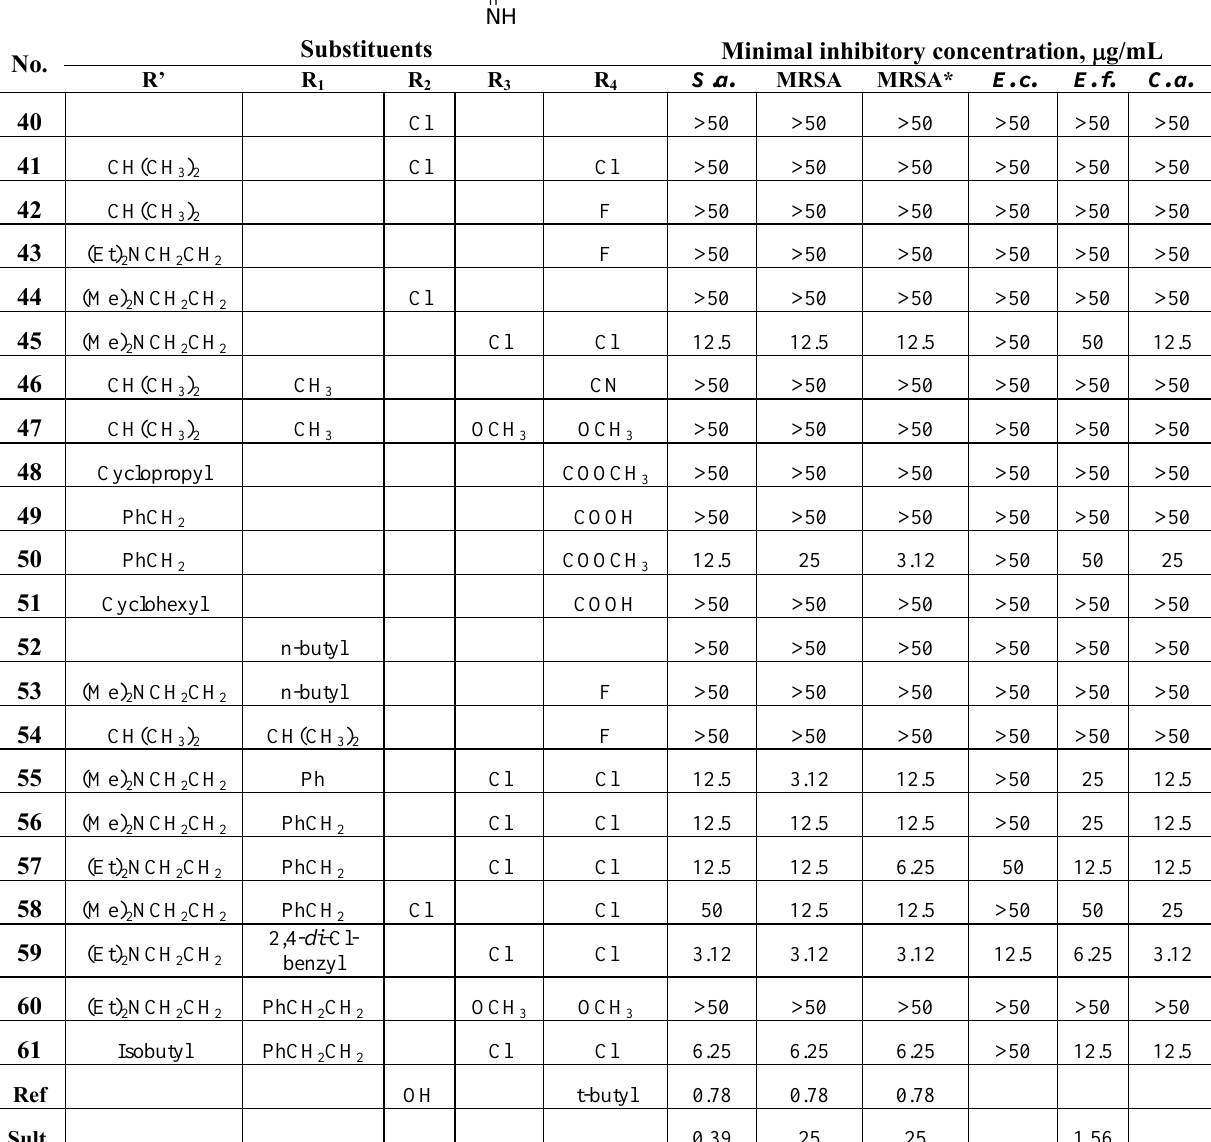
Table 1 . Formulas and in vitro antibacterial and antifungal activities of 40 - 61